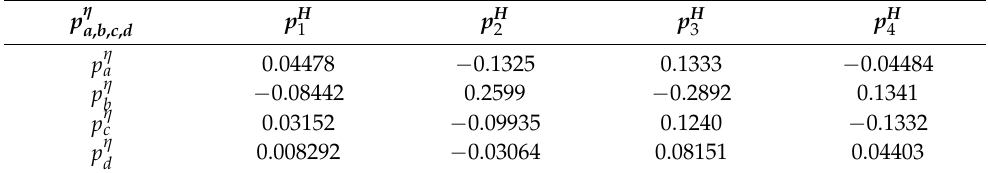
Table A1. Parameter fitting results of coefficients in Equation (A8) for empirical model functions. p η a , b , c ,